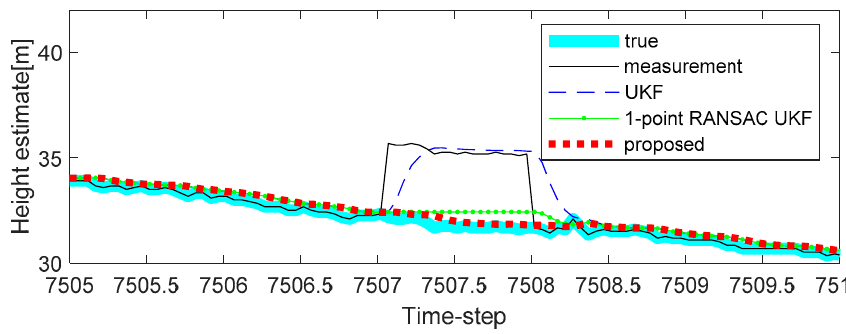
Figure 5. The first experimental results of height estimation with bias type measurement error in the first period (7507 to 7508 time-step): case 1.